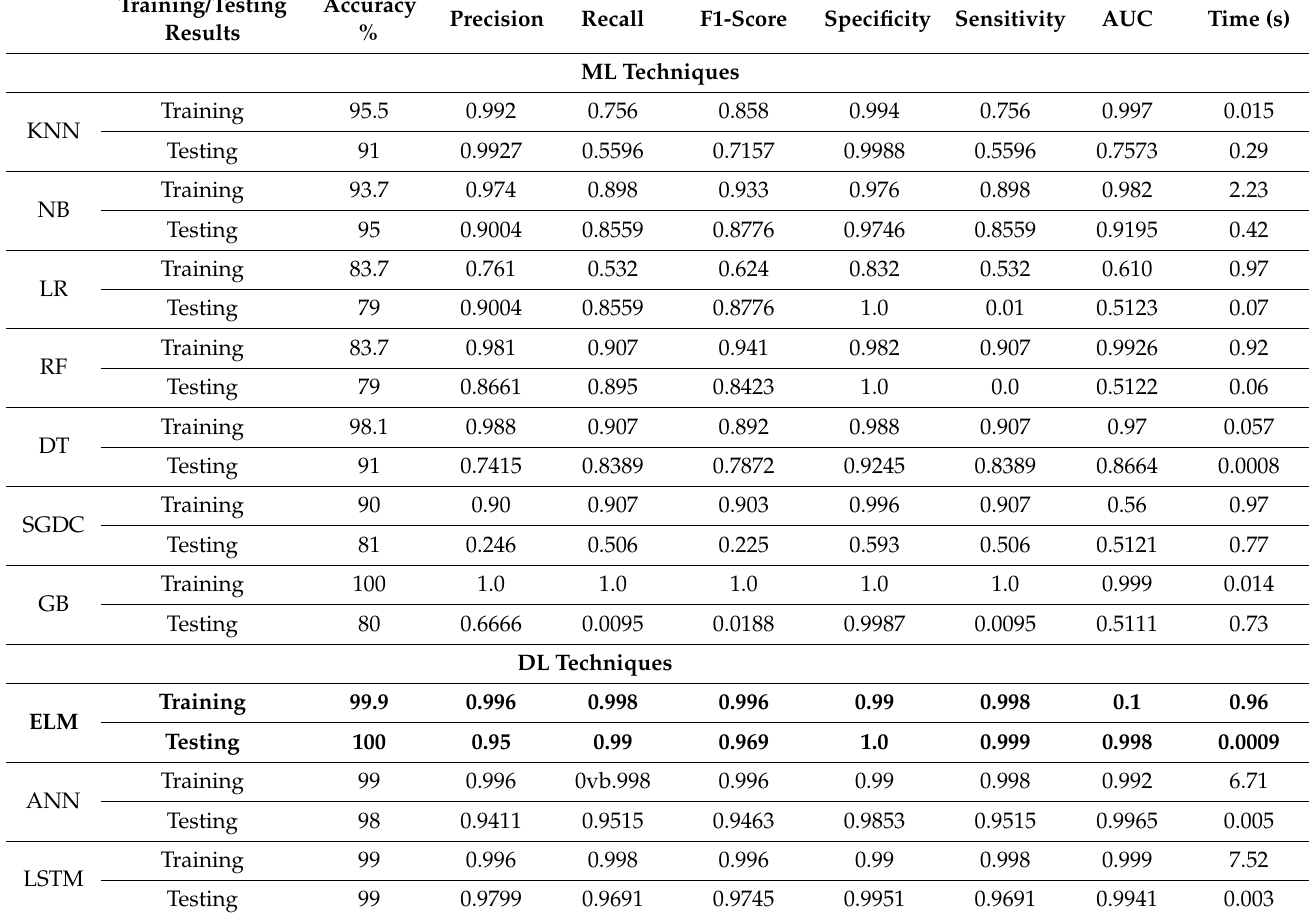
Table 7. The performance comparison of different